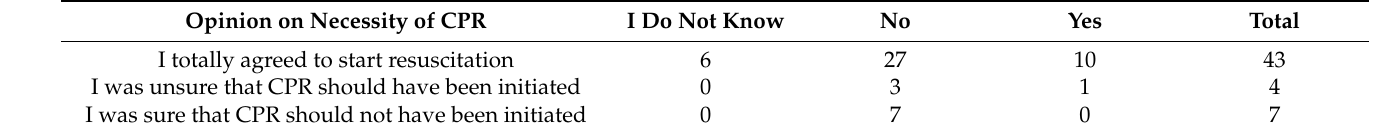
Table 6. The perception of the utility of the initiation of CPR vs. ROSC.